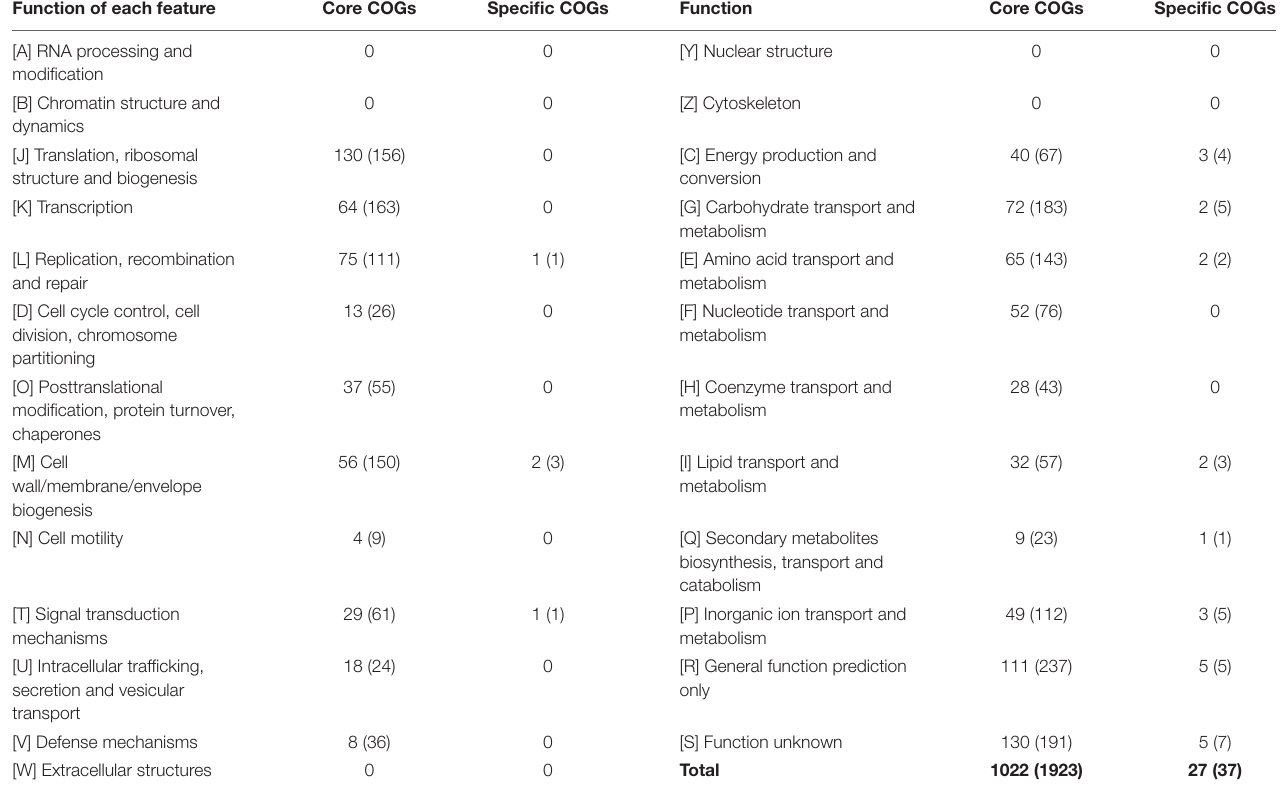
TABLE 4 | Features of core and strain-specific COGs present in the E. lacertideformus assembly. Function of each feature Core COGs Specific COGs Function Core COGs Specific